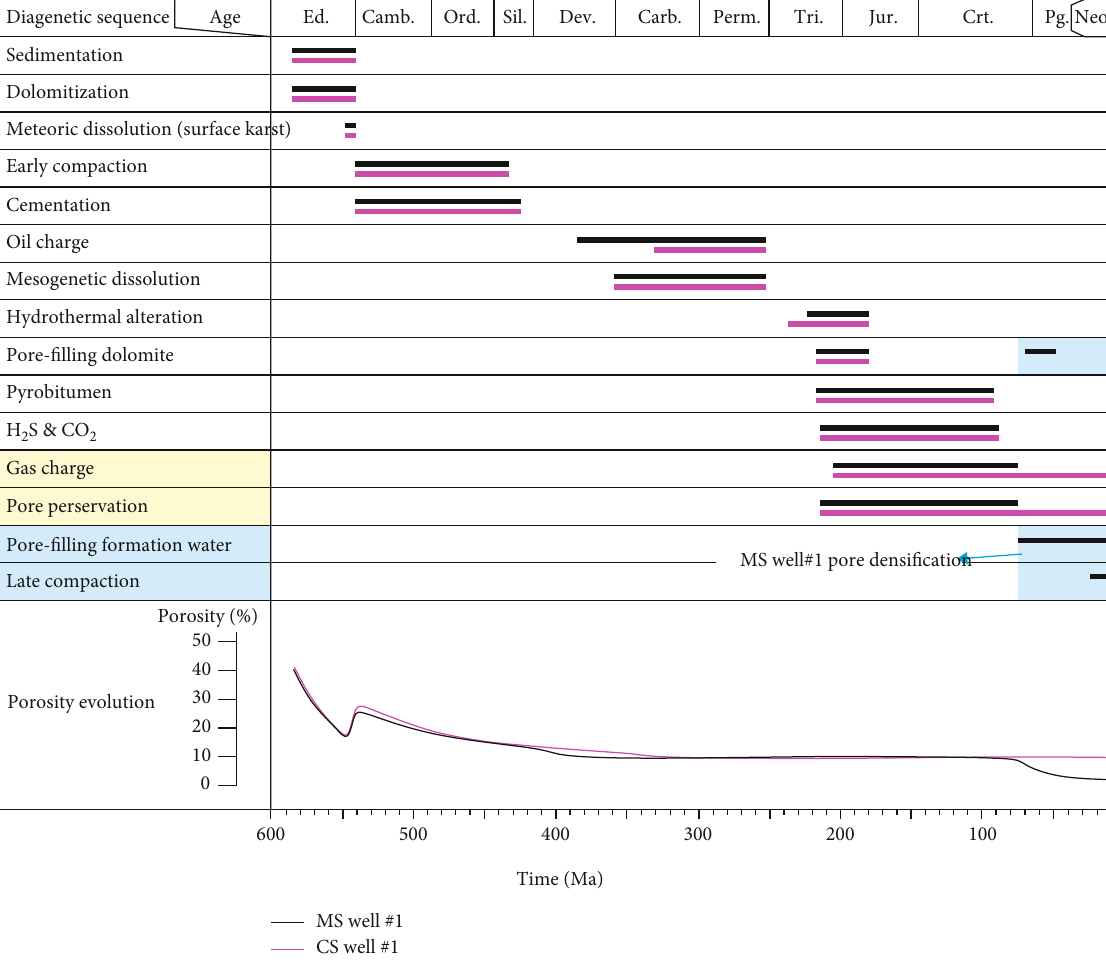
dn 4 member during the formation of dolomite reservoirs. Note 2